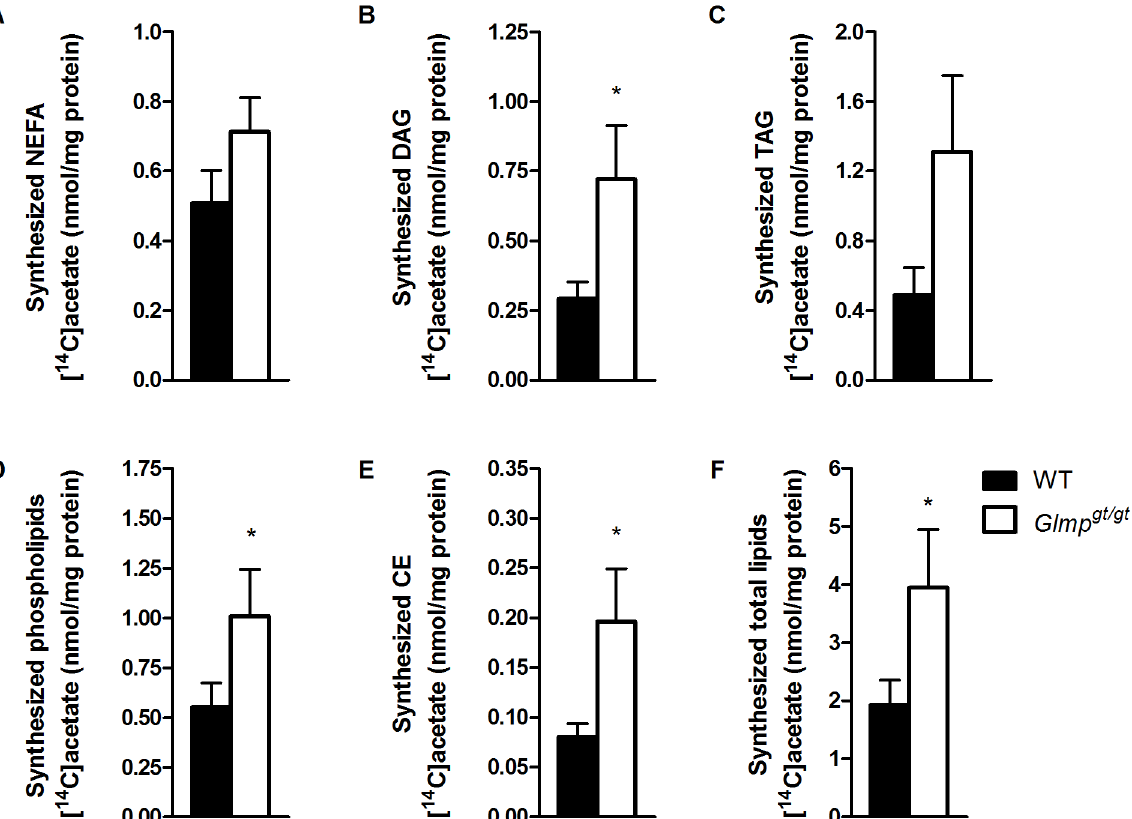
Fig 7. Increased de novo lipogenesis in Glmp gt/gt hepatocytes. Overnight cultured primary hepatocytes from WT and Glmp gt/gt mice were incubated with [ 14 C]acetate (0.5 μ Ci/mL, 100 μ M) for 4 h. (A) The amount of synthesized non-esterified fatty acids (NEFA), (B) diacylglycerol (DAG), (C) triacylglycerol (TAG), (D) phospholipids, (E) cholesterol esters (CE) and (F) total lipids were analyzed using thin layer chromatography (n = 8 experiments, representing 4 individual mice/genotype, with 2 replicates each, * p < 0 . 05 vs. WT). Values are presented as mean ±